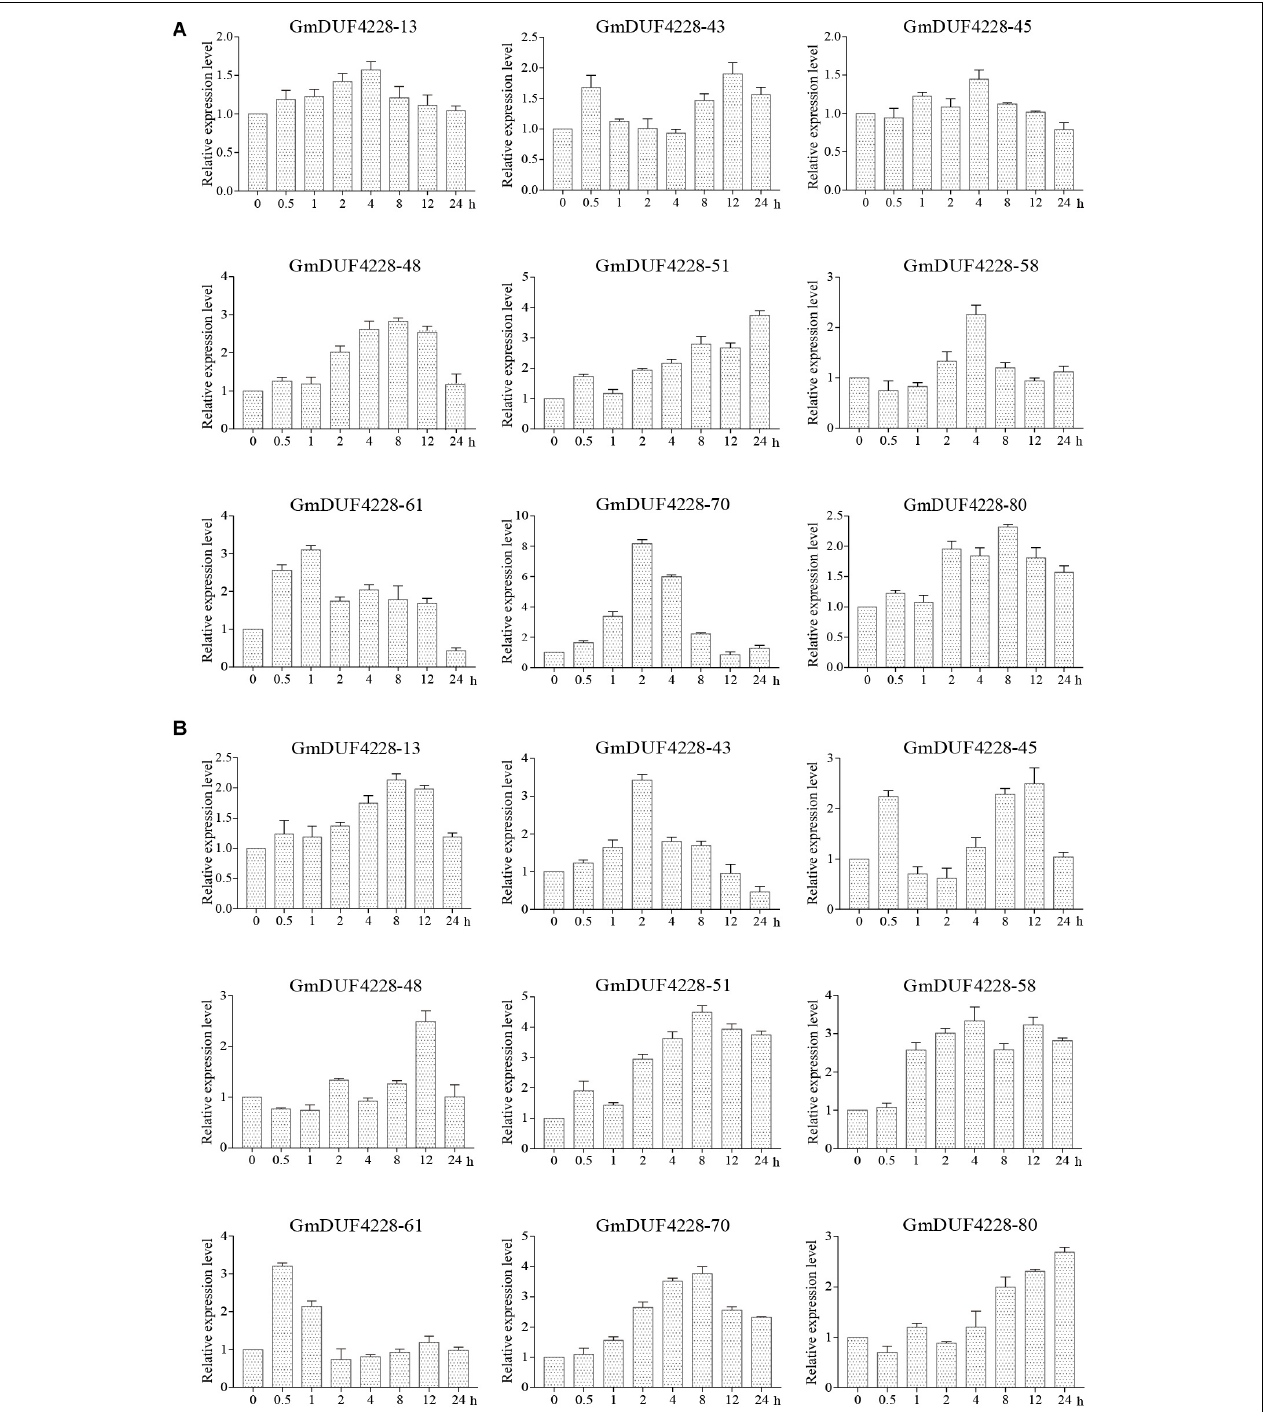
FIGURE 7 | Expression patterns based on qRT-PCR of nine GmDUF4228 genes under drought and salt stresses. (A) Drought treatment under 0, 0.5, 1, 2, 4, 8, 12, and 24 h. (B) Salt treatment (200 mM NaCl) for 0, 0.5, 1, 2, 4, 8, 12, and 24 h. Data are presented as mean ± standard deviation ( n = 3).